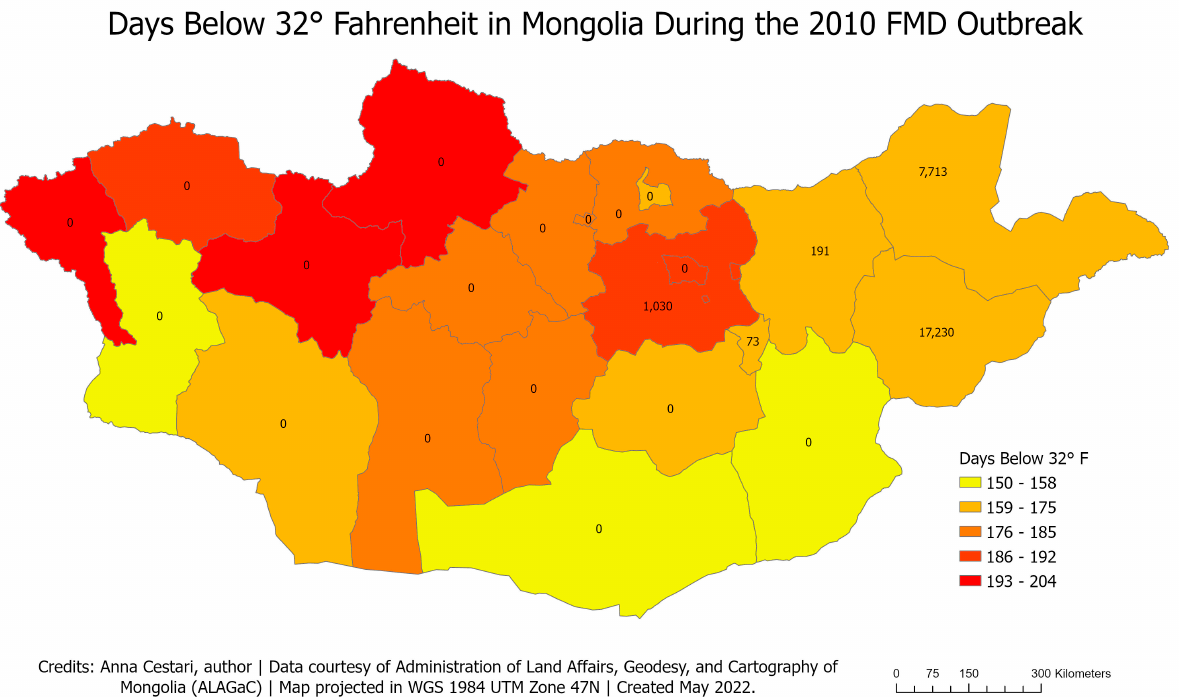
Figure 6. This map shows the provinces in Mongolia with the color shading based on the number of days with temperature below 32 °F. The darker colors represent more days below 32 °F. Each province is labeled with its number of foot and mouth disease cases for the 2010 outbreak.